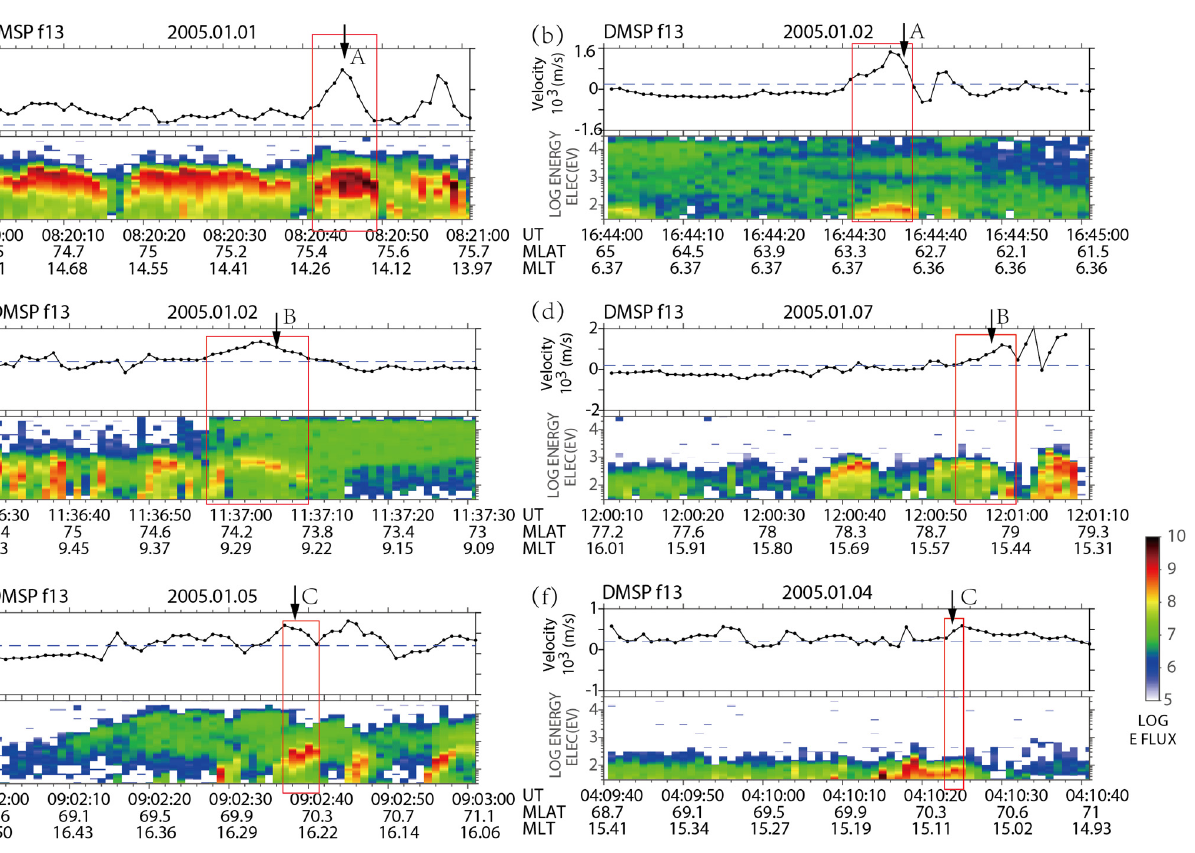
Figure 1. Corresponding relationship between the vertical ion drift velocity (top panel) and electron acceleration (bottom panel) for different types of ion upflows. The horizontal blue dashed line is the threshold value of 200 m/s. The red box indicates the interval of typical ion upflows, and the black arrow and the letters (A–E) next to it indicate the type of ion upflows. ( a , b ) Type A ion upflows, ( c , d ) type B ion upflows, ( e , f ) type C ion upflows, ( g , h ) type D ion upflows, ( i ) type E ion upflows.